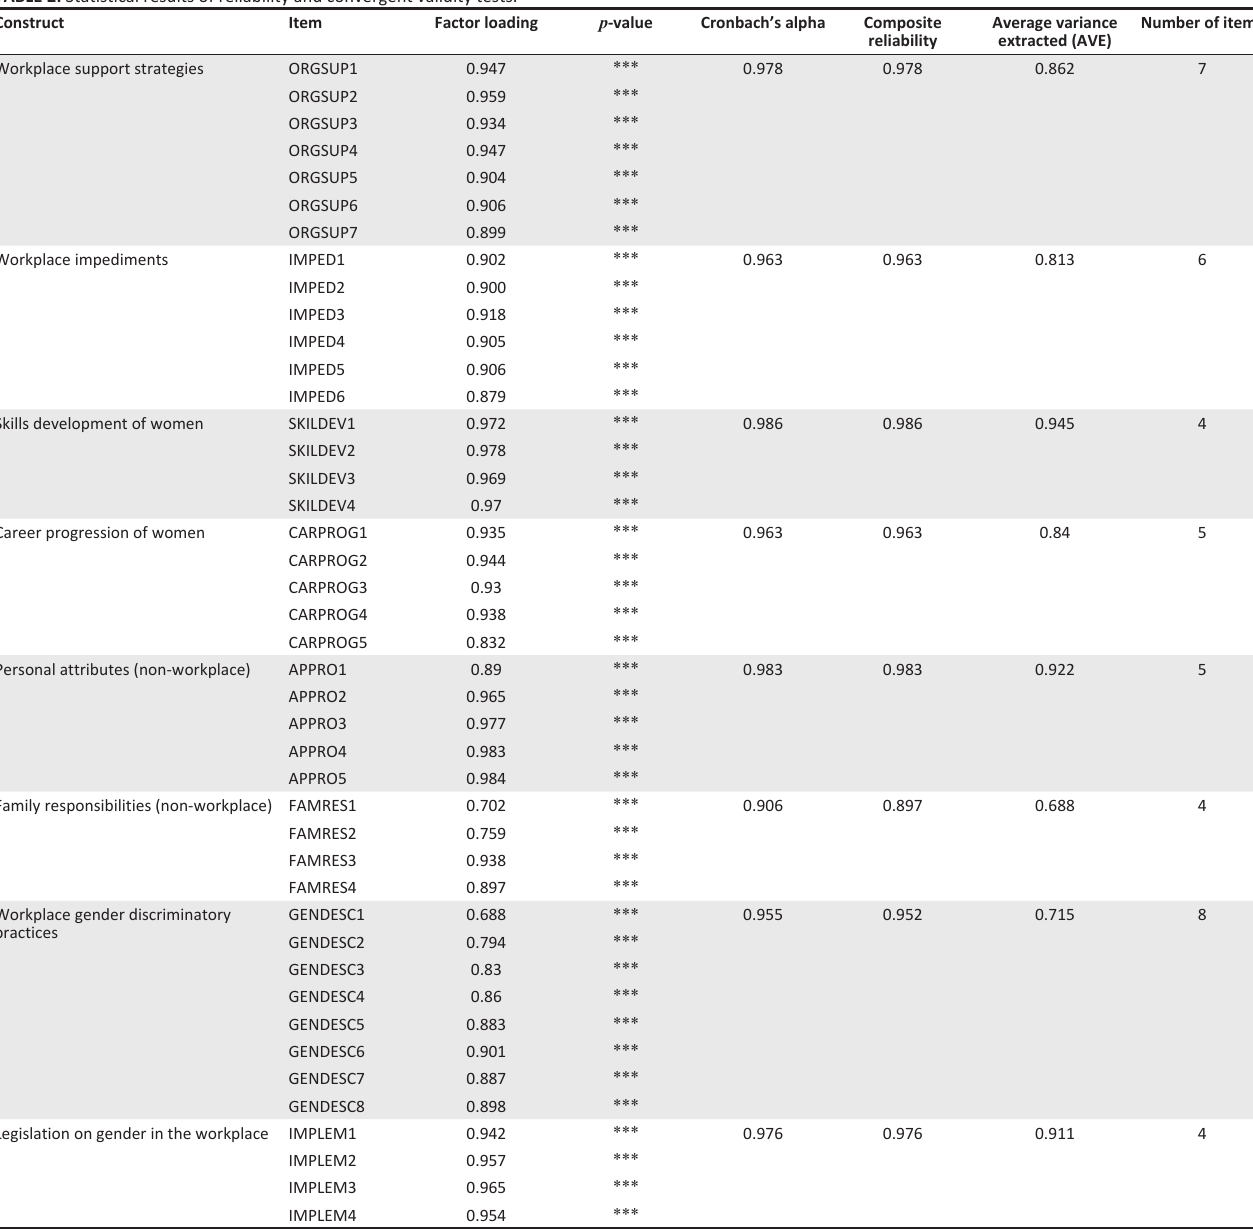
TABLE 2: Statistical results of reliability and convergent validity tests.